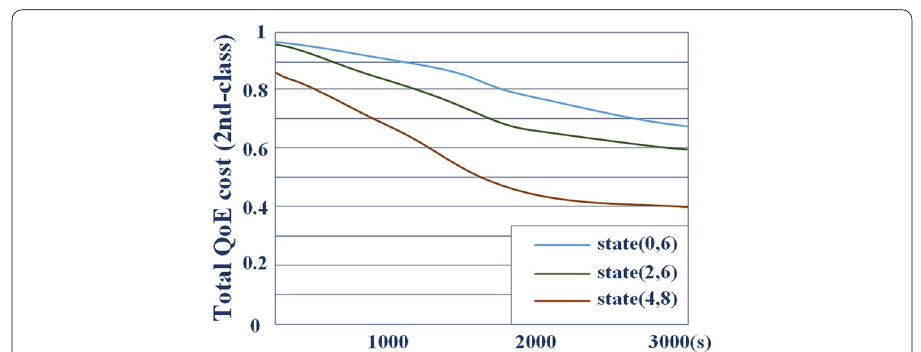
Fig. 12 QoE (class-2) under different initial